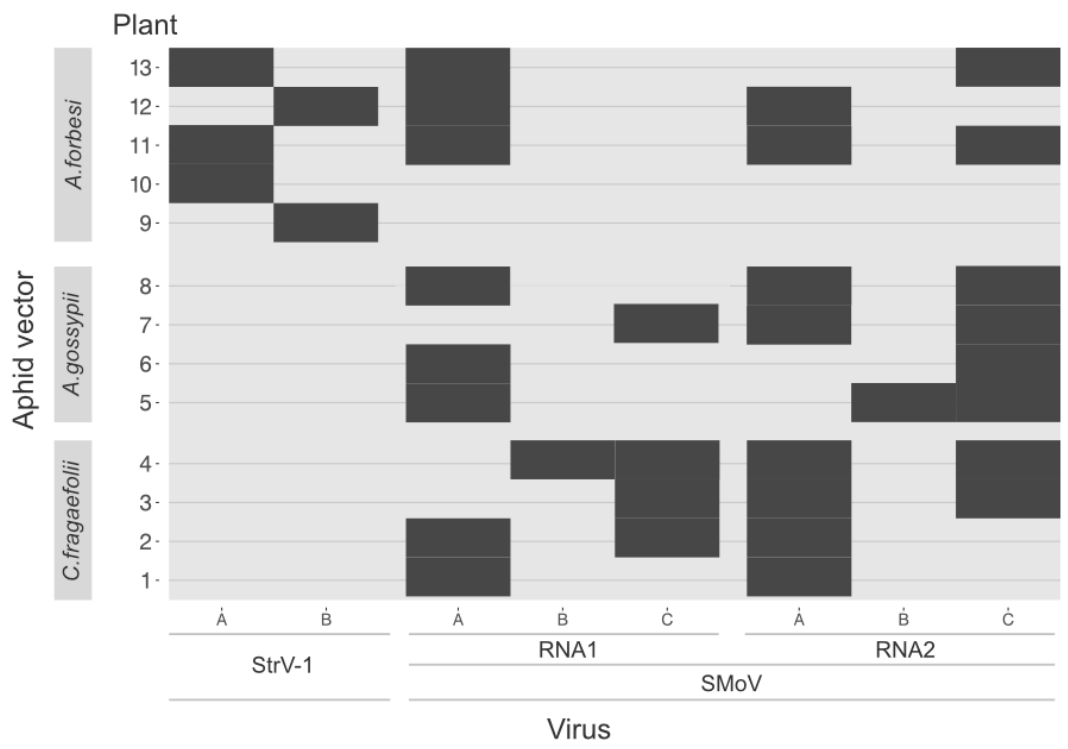
Figure 6. Results of testing of F. vesca plants 30 dpi following single aphid transmission with an inoculation access period of 24 h. Black rectangles indicate positive detection.